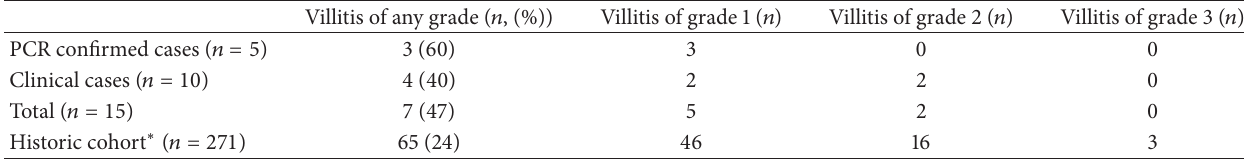
Table 3: Number of placentas with chronic villitis, divided by proven or suspected infection and grade of villitis. Villitis of any grade ( 𝑛 , (%)) Villitis of grade 1 ( 𝑛 )